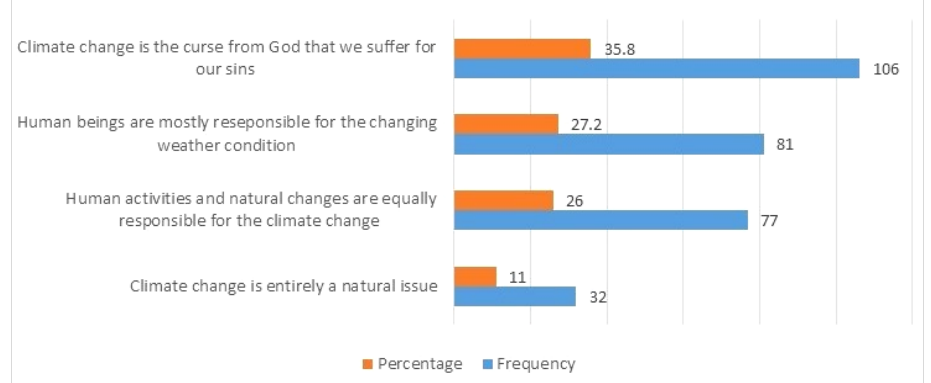
Fig. 1. Respondents’ perceptions about the causes of climate change (Source: Survey, April